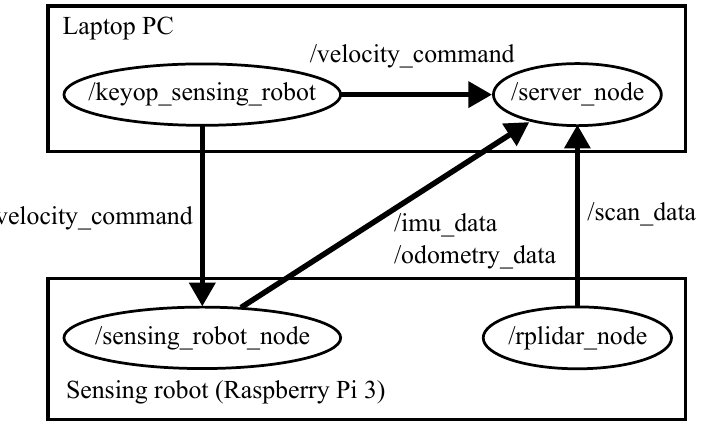
Figure 10. ROS-based